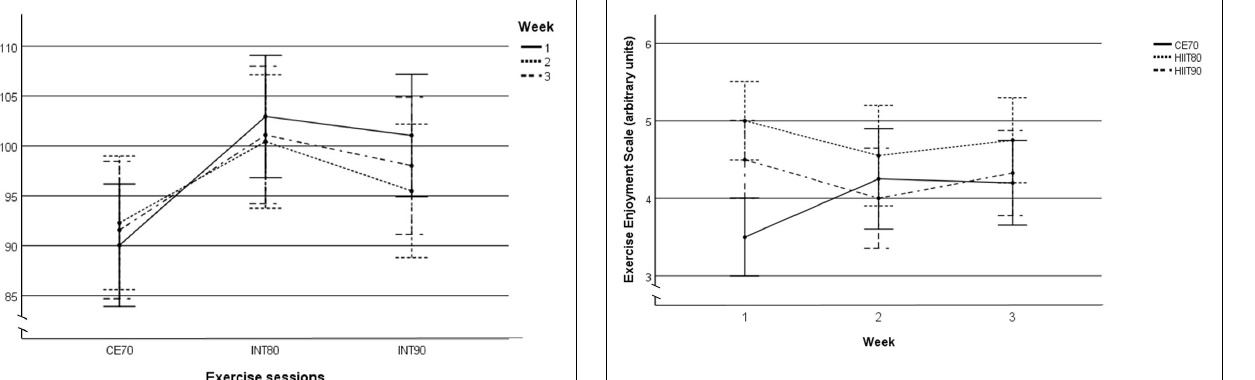
FIGURE 4 | Mean EES score during the exercise sessions in all three weeks separately. Week × exercise session interaction: p = 0.01, p η 2 : 0.11. Data are shown as mean and 95% CI. PACES, Physical Activity Enjoyment Scale; INT90, interval exercise session at > 90% of HR max ; INT80, interval exercise session at > 80% of HR max ; CE70, continuous moderate intensity exercise at 70% of HR max ; CI, confidence interval. 0.71), with higher exertion by higher intensity sessions (CE70